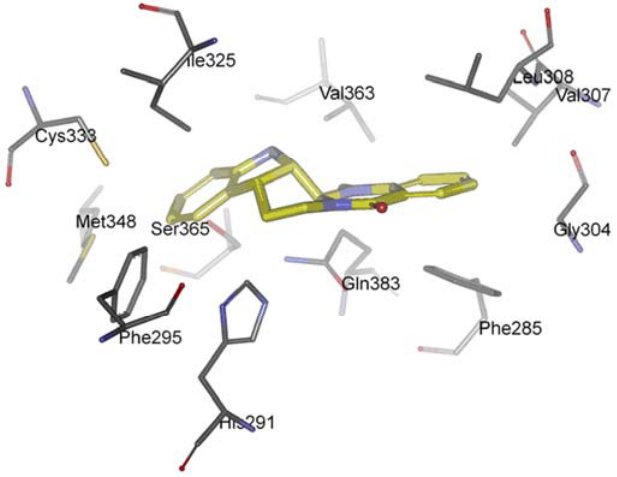
Figure 6. Docking orientation of evodiamine within the AhR-LBD binding